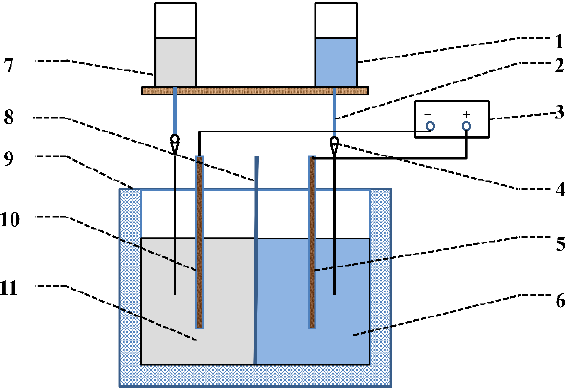
Figure 1. Experimental device diagram. (1)—Cathode electrolyte, (2)—Feeding pipe, (3)—DC power, (4)—Rotameter, (5)—Cathode plate, (6)—Cathode chamber, (7)—Anode electrolyte, (8)—Diaphragm, (9)—Electrolyzer, (10)—Anode plate, (11)—Anode chamber. The basic principle of preparing Mg(OH) 2 by electrolytic bischofite aqueous solution can be expressed by the following electrode The dissolved and filtered bischofite was used as the magnesium source, and the concentration of Mg 2+ in the electrolyte was controlled to 0.35 mol/L. During the experi- ment, the current density was adjusted to 0.05 A/cm 2 , and the reaction temperature was 25 °C.